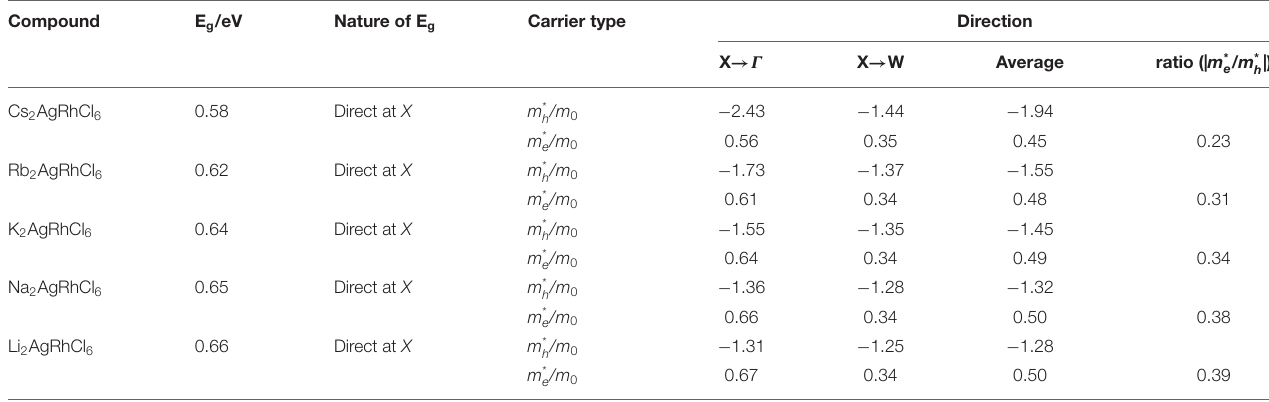
TABLE 4 | Non-spin-polarized effective masses of electrons and holes obtained using the parabolic fitting of the lower conduction band and upper valence band for A 2 AgRhCl 6 ( A Cs, Rb, K, Na, Li) a . Primitive cells used. = Compound E g /eV Nature of E g Carrier type Direction